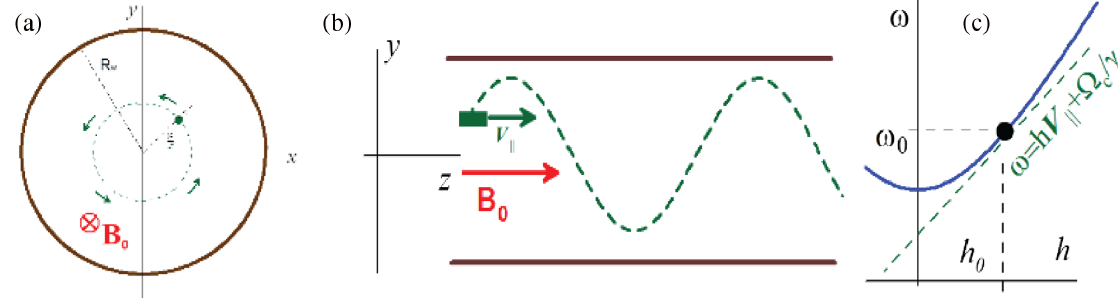
FIG. 2. (a) Cross section of the cavity. (b) Longitudinal section of the cavity. (c) Dispersion characteristic for the case when the electron velocity is close to the group velocity of the radiated